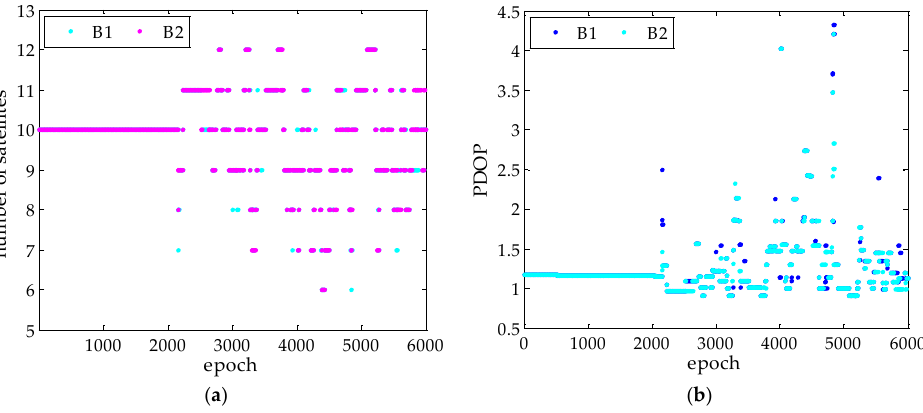
Figure 6. Visible satellite number and PDOP for the each baseline in kinematic experiment: ( a ) shows the visible satellite number; and ( b ) reflects the PDOP of PAD method.